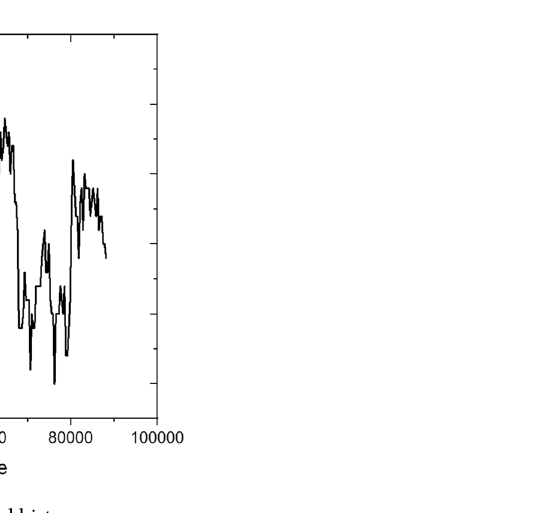
Figure 14. Real time maximum forming load